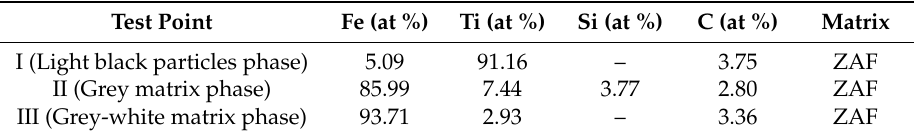
Figure 5. The BSE image of the laser cladding zone. I: Light black particles phase; II: grey matrix phase; and III: grey-white matrix phase. Table 1. EDS analysis data of the different phases in Figure 5.